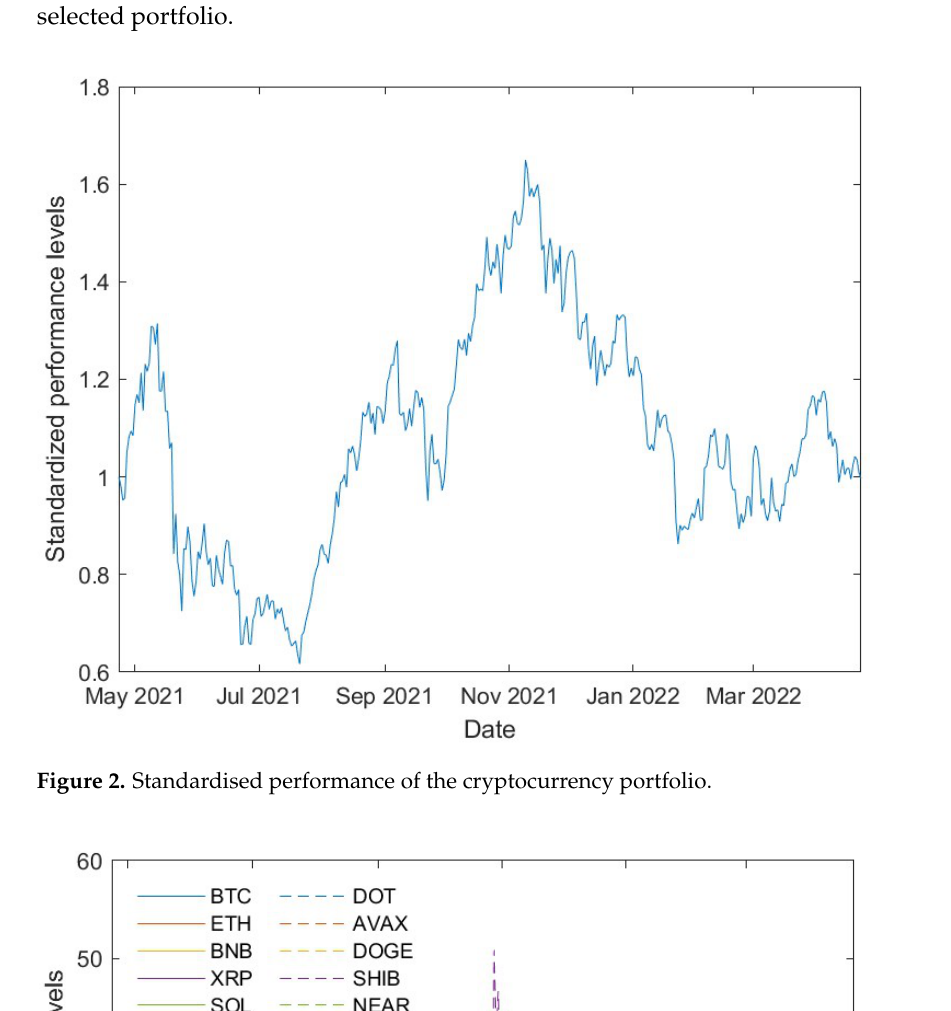
Figure 2. Standardised performance of the cryptocurrency portfolio.